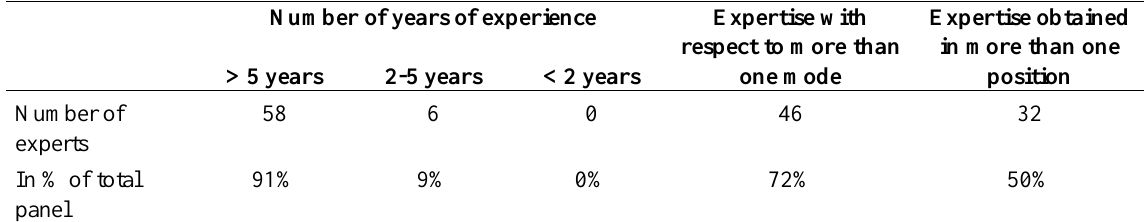
Table 3. Indication expertise of the Delphi